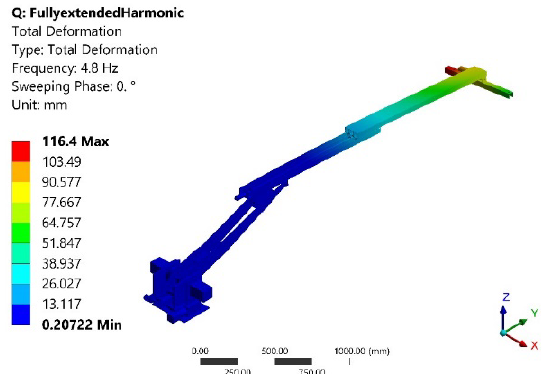
Figure 13. Total deformation (in mm) of the fully-extended configuration of the manipulator, resulting from the harmonic analysis at the first natural frequency (4.8 Hz).